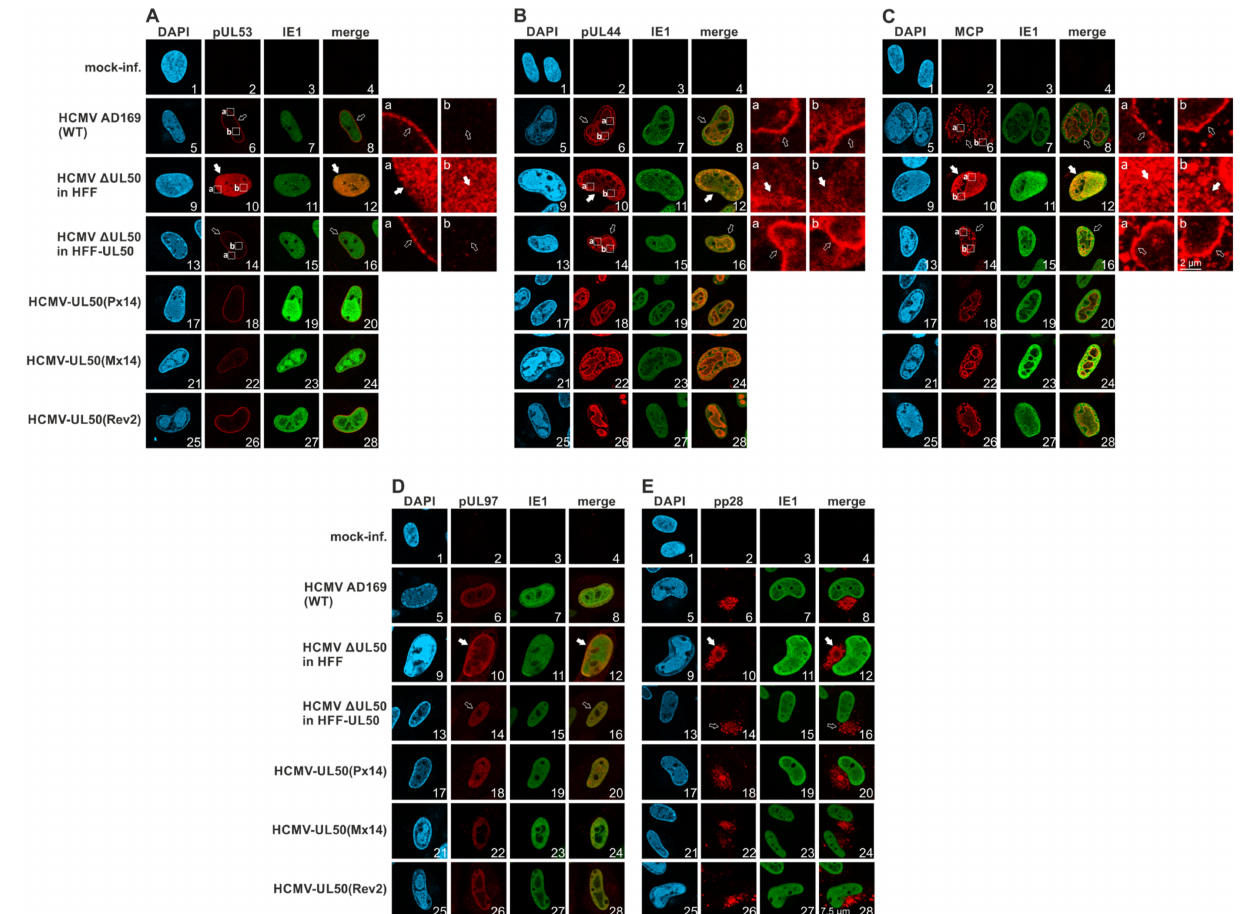
Figure 4. Confocal imaging analysis of the localization of viral proteins produced by HCMV ∆ UL50 or pUL50 phosphosite mutations. Normal HFFs or pUL50-complementing cells (HFF-UL50 +Dox) were used for infection with the recombinant HCMVs at a MOI of 0.05 and harvested at 7 d p.i. Immunofluorescence staining was performed with antibodies against the indicated proteins and representative panels of confocal imaging are given (see scale bar in panel E, picture 28). ( A – C ) Viral proteins pUL53, pUL44 and MCP, showing altered localization patterns for HCMV ∆ UL50 in HFF (see insets a and b and the phenotype of altered localization marked by filled white arrows, compared to normal/unaltered localization marked by framed white arrows). ( D , E ) Viral proteins pUL97, IE1 and pp28, showing no alteration in localization patterns. Additional information is provided by Figure